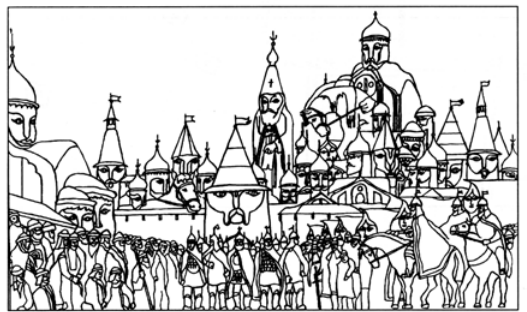
fig. 12. PTW, Beijing, China, 2004–2007. © CSCEC + PTW + CCDI and